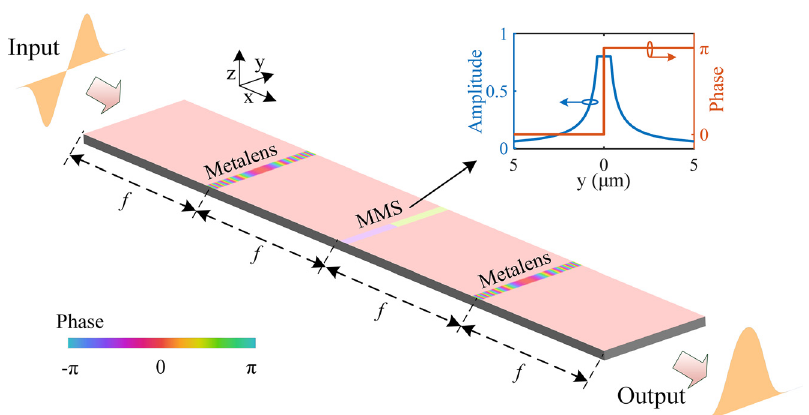
Figure 1: Schematicdiagram of the proposed integrator. The color of the three metasurfaces inthediagramrepresentsthe phase